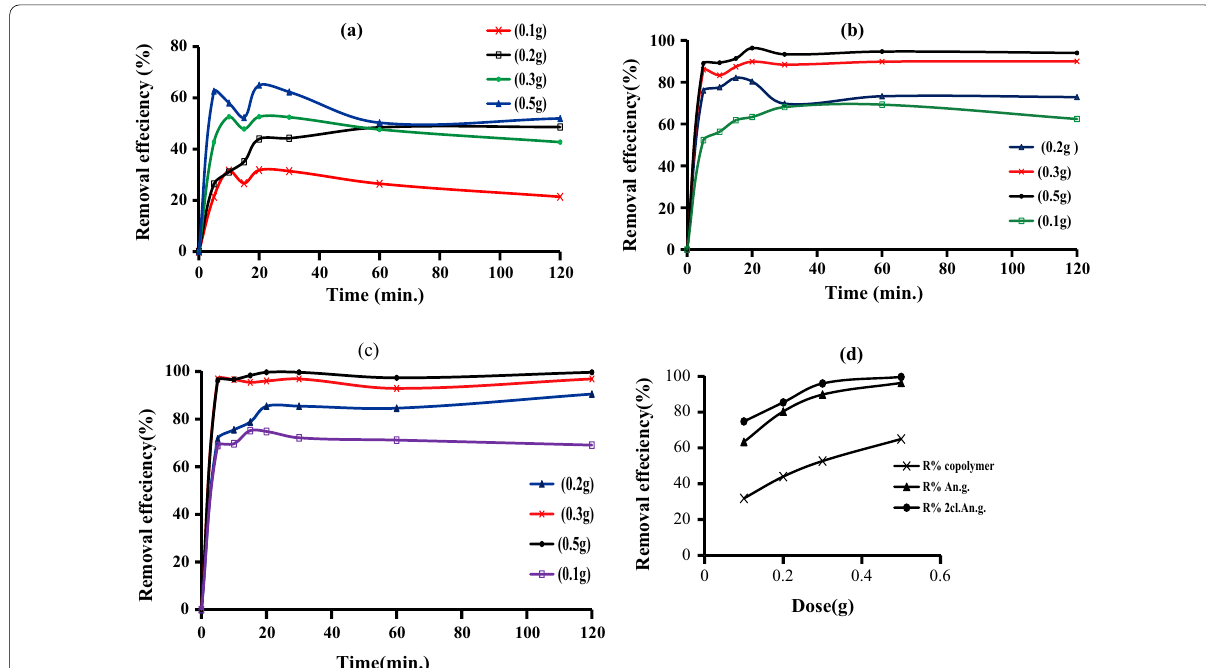
Fig. 7 Removal efficiency (%) of copolymer ( a ), aniline graft ( b ) and 2‑chloroaniline graft ( c ) doses at different time intervals at contact time 20 m for three samples ( d